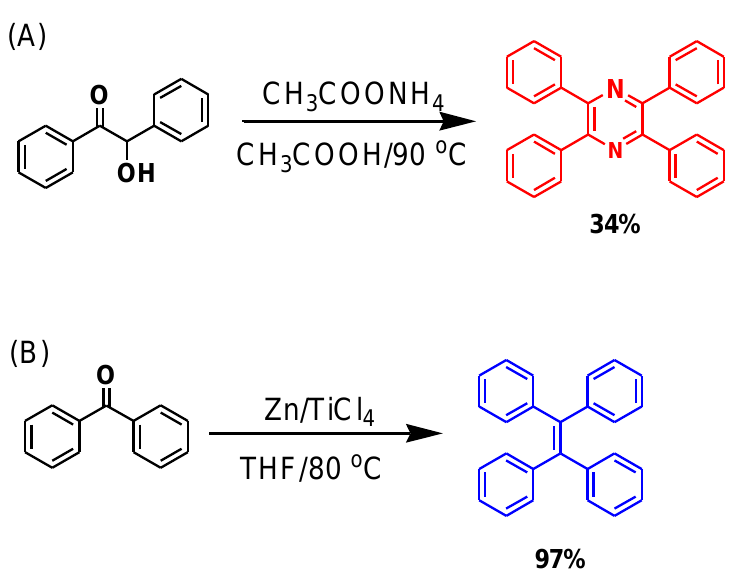
Scheme 1. Synthesis of ( A ) tetraphenylpyrazine (TPP) and ( B ) tetraphenylethene (TPE).